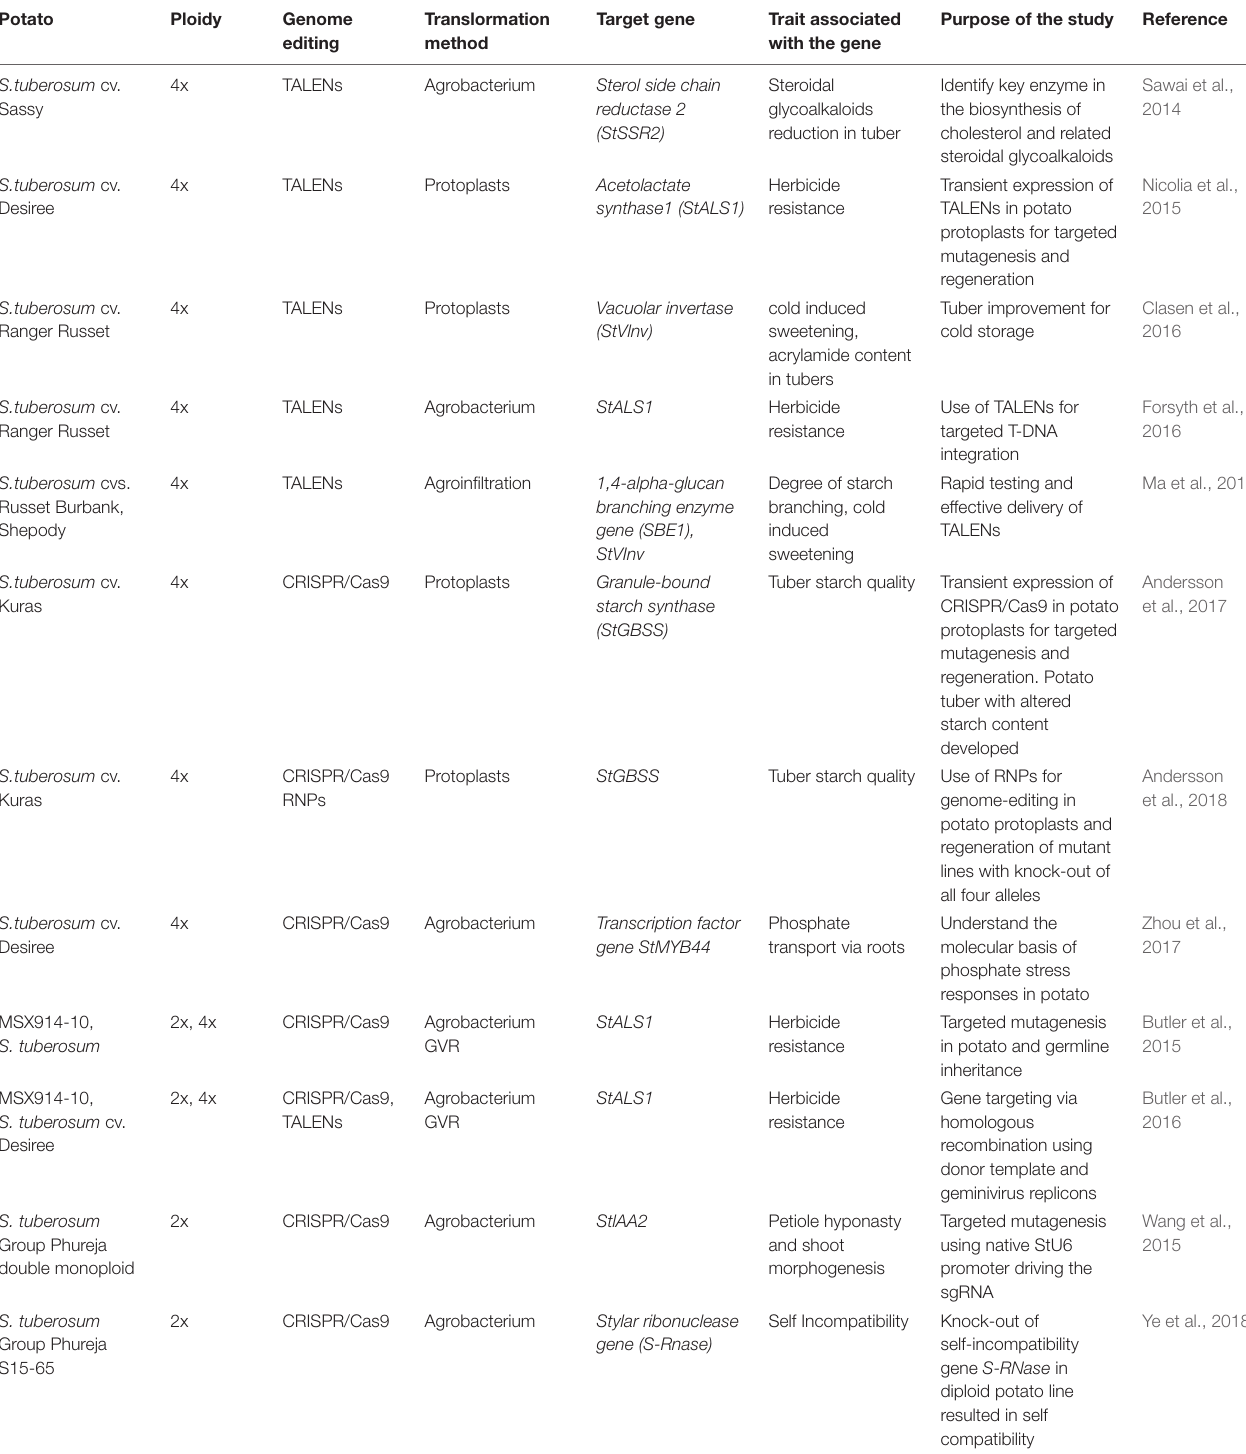
TABLE 1 | Genome editing case studies in clonally propagated crops.